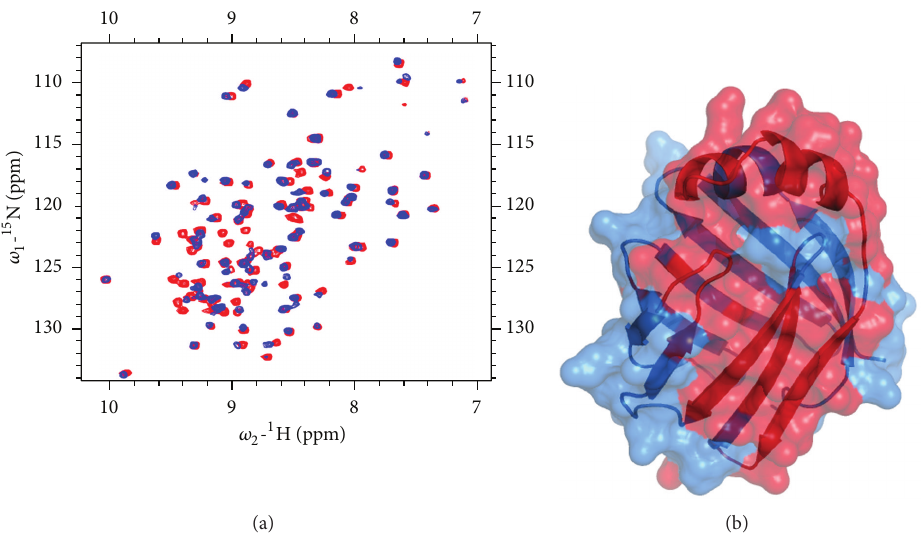
Figure 5: (a) 1 H- 15 N HSQC spectrum of apo-L-FABP (red) overlaid on top of the spectrum of holo-PPAR 𝛼 LBD-L-FABP (blue). (b) The highly affected residues ( > 0.6p.p.m perturbation) are mapped onto the crystallographic structure of human L-FABP (PDB code: 2F73).